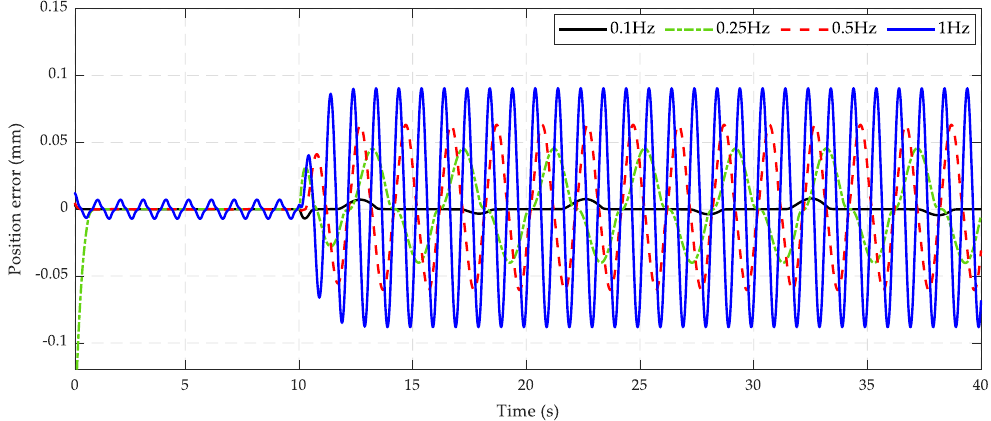
Figure 7. Performance tracking errors under di ff erent frequencies of the desired input signals in the case of no external loading condition.